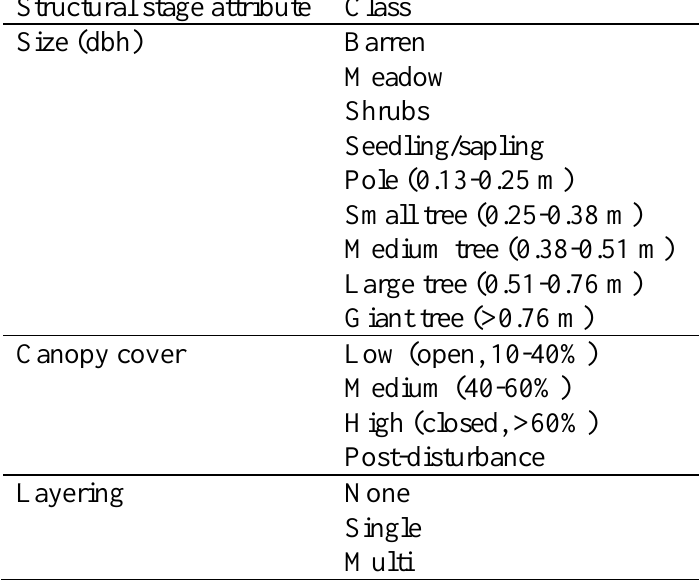
Table A1.2 . Structural stage attributes assigned to each of 39 potential vegetation types (PVT, Table A1.1) to define 565 unique vegclasses, thus each vegclass includes a combination of PVT, tree size, canopy cover and